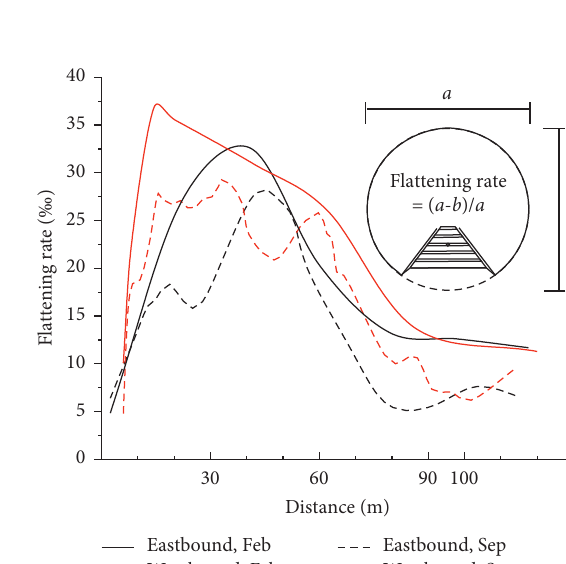
Figure 20: Joint